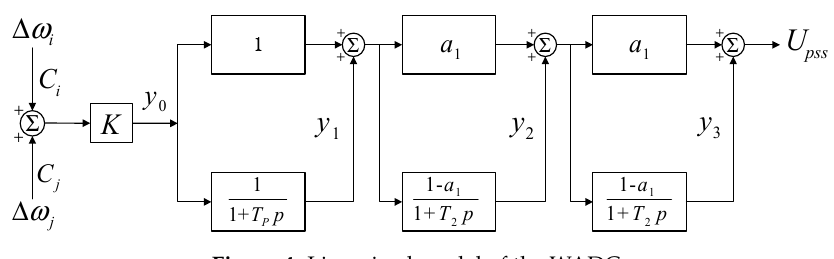
Figure 4. Linearized model of the WADC.